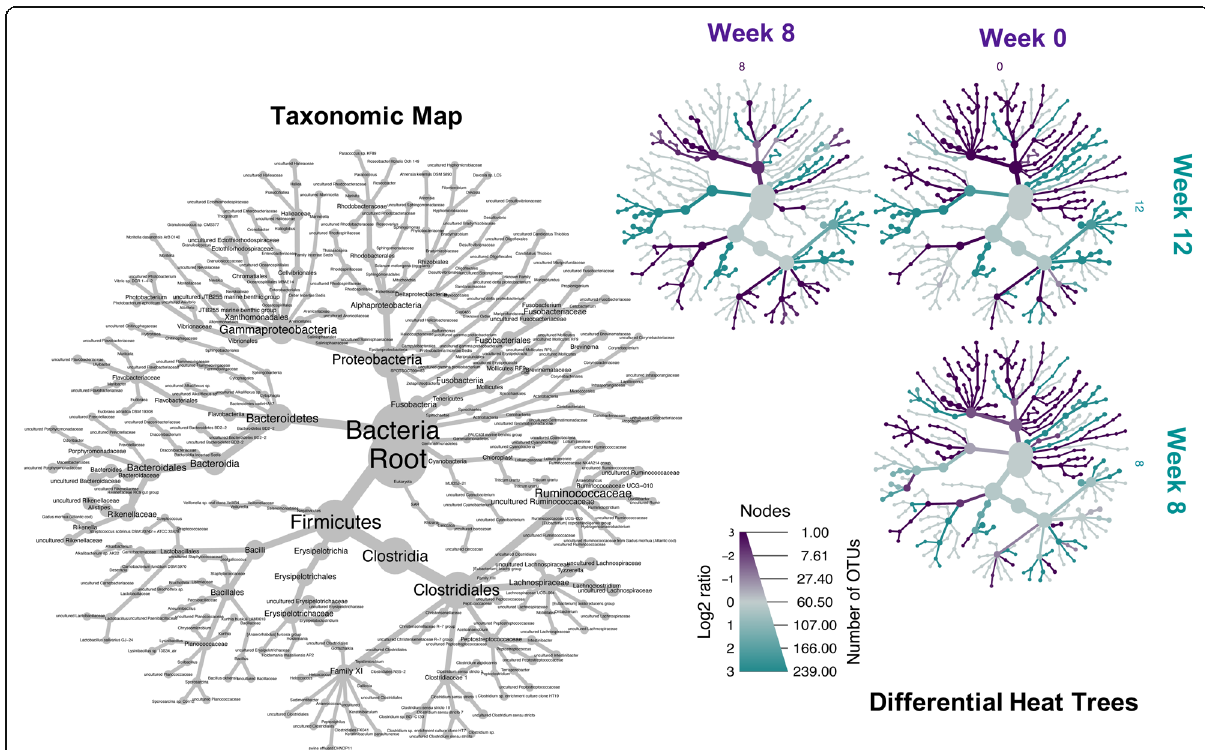
Fig. 4 Differential taxa in the hindgut microbiota of juvenile Atlantic cod ( Gadus morhua ). These taxa were first determined using sPLS-DA with the discriminating operational taxonomic units (OTUs) at > 1% relative abundance at Week 0, Week 8 and Week 12 (excluding ASCO_LG fish). The taxonomic map is a legend to show the identity of the differentiating taxa. This legend is read to inform the differential heat trees. The differential heat trees show the microbiota shifts from Week 0, Week 8, and Week 12. The branches where they are upregulated are coloured according to their respective categories shown for each tree (Week 0, Week 8, and Week 12). The nodes legend can be read as follows: Left side ‘ Log2 ratio ’ of the median proportions of the taxa corresponding to the colour scale, Right side ‘ Number of OTUs ’ where the diameter reflects the number of OTUs corresponding to the nodes on the heat